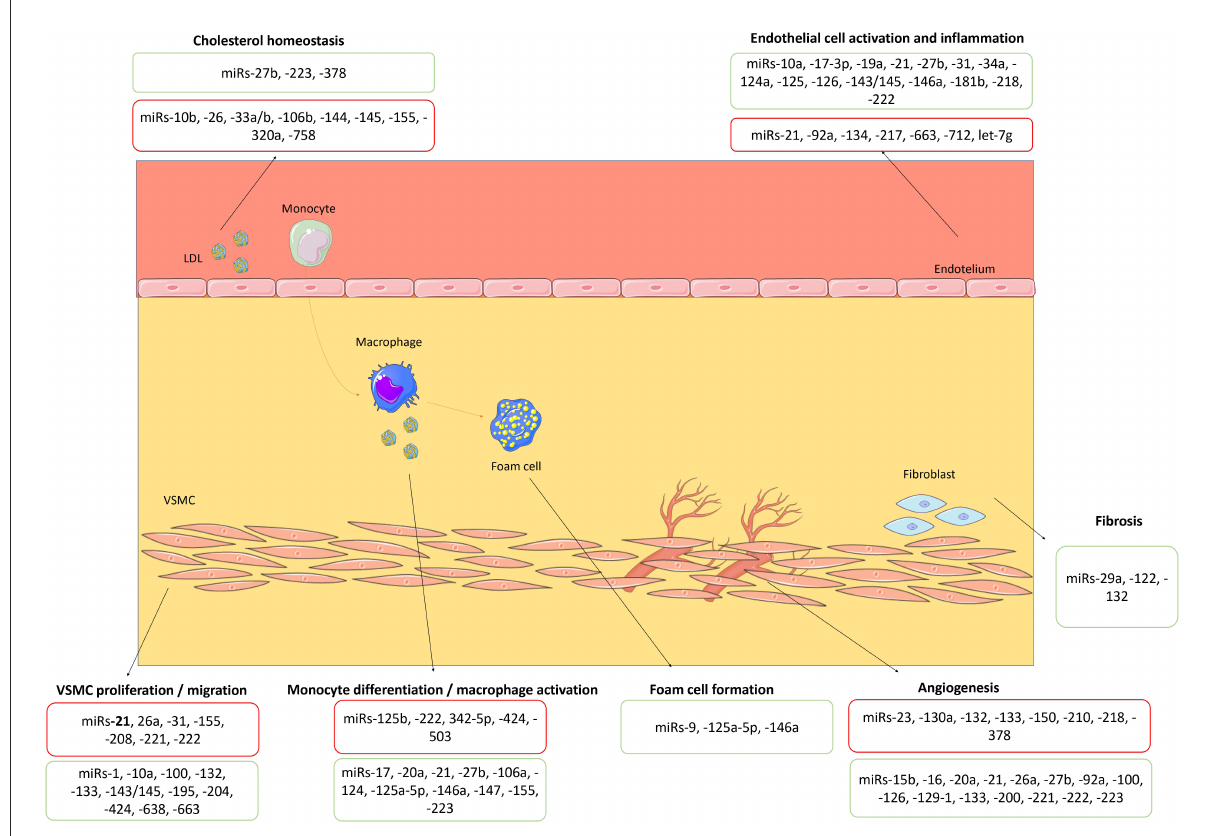
FIGURE1 Biological roles of miRNAs in atherosclerosis’s pathophysiology. miRNAs with proatherogenic and atheroprotective effects are highlighted in red and green boxes, respectively. VSMC, vascular smooth muscle cell. The figure was partly generated using Servier Medical Art, provided